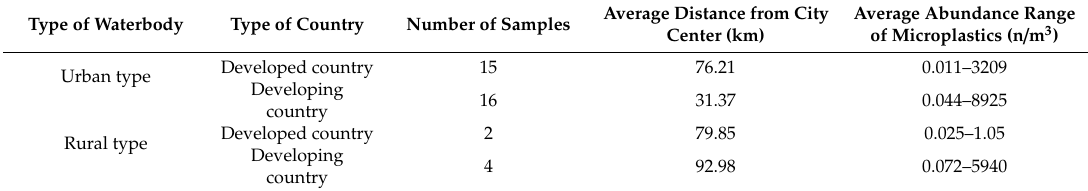
Figure 4. The average content of microplastics in freshwater bodies in urban and rural areas of the the world. world. Table 5. Comparison table of the microplastic concentration in urban and rural Table 5. Comparison table of the microplastic concentration in urban and rural waterbodies.